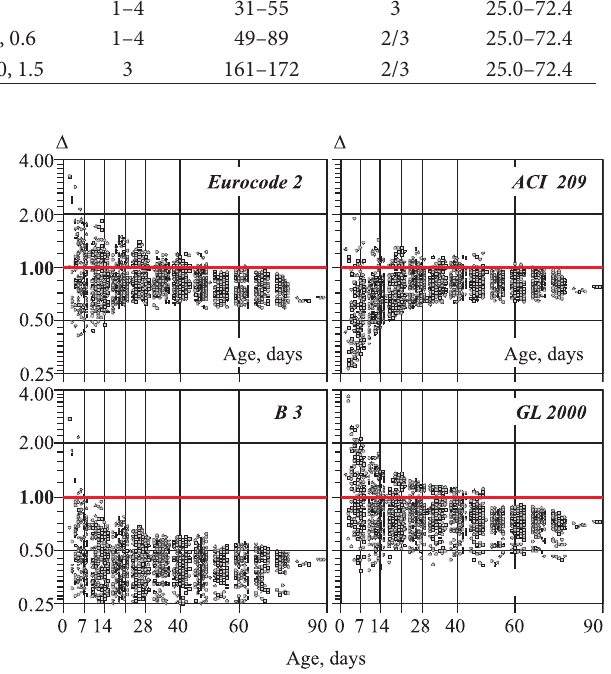
Fig. 5. The shrinkage prediction of ordinary